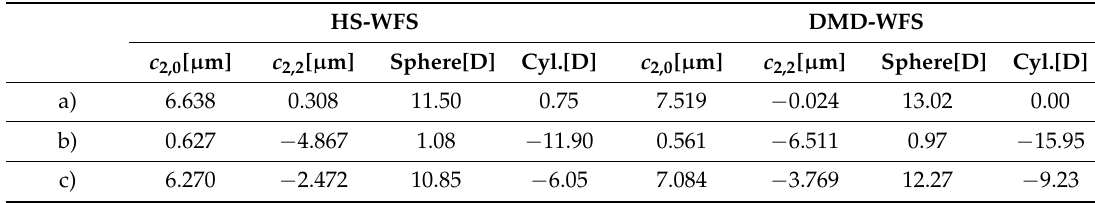
Table 1. Data comparison between the Zernike coefficients c 2,0 and c 2,2 and the equivalent sphere and cylinder power for a 4 mm pupil, with an artificial eye obtained by the HS-WFS and the DMD-WFS without binning.